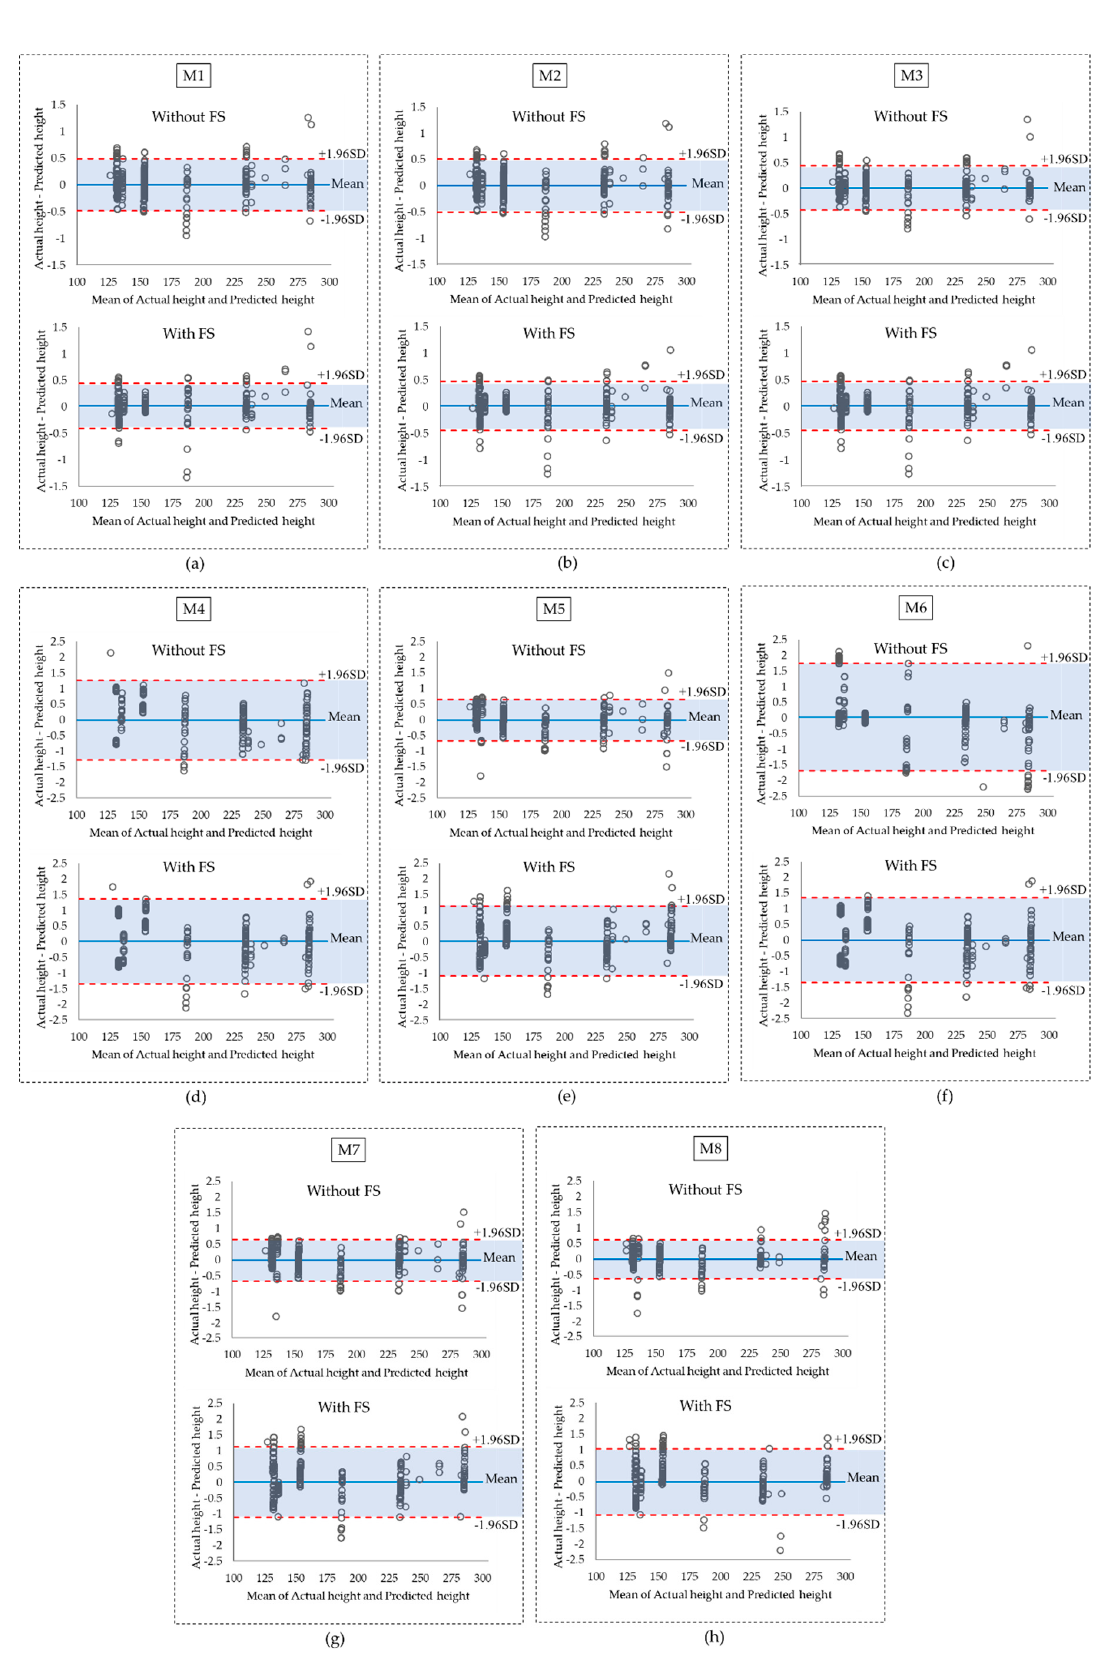
Figure 8. The Bland–Altman plots for error values before and after feature selection for ( a ) M1, ( b ) M2, ( c ) M3, ( d ) M4, ( e ) M5, ( f ) M6, ( g ) M7, and ( h ) M8. The blue shaded areas represent the confidence intervals around the mean.